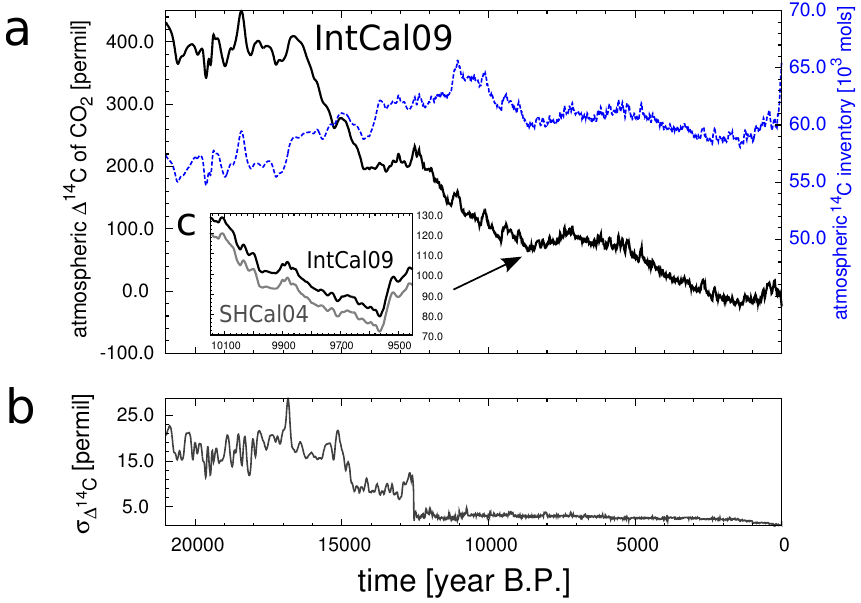
Fig. 2. (a) Reconstructed atmospheric 1 14 C of CO 2 (black, left axis) and the atmospheric radiocarbon inventory (blue, right axis) over the past 21kyr. From 21 to 11kyrBP, radiocarbon data are from IntCal09 (Reimer et al., 2009). Afterward, we use IntCal09 data for the Northern Hemisphere and SHCal04 (McCormac et al., 2004) for the Southern Hemisphere, thereby taking into account the interhemispheric gradient of approximately 8‰ and hemisphere-specific anthropogenic depletion of 14 C during the industrial period. The two records are not distinguishable in this figure because of their proximity – see (c) for a zoom-in. The atmospheric radiocarbon inventory is computed from the 1 14 C records and the CO 2 record from Monnin et al. (2004). (b) The 1 σ error assigned to the 1 14 C record and used as input for the Monte Carlo uncertainty